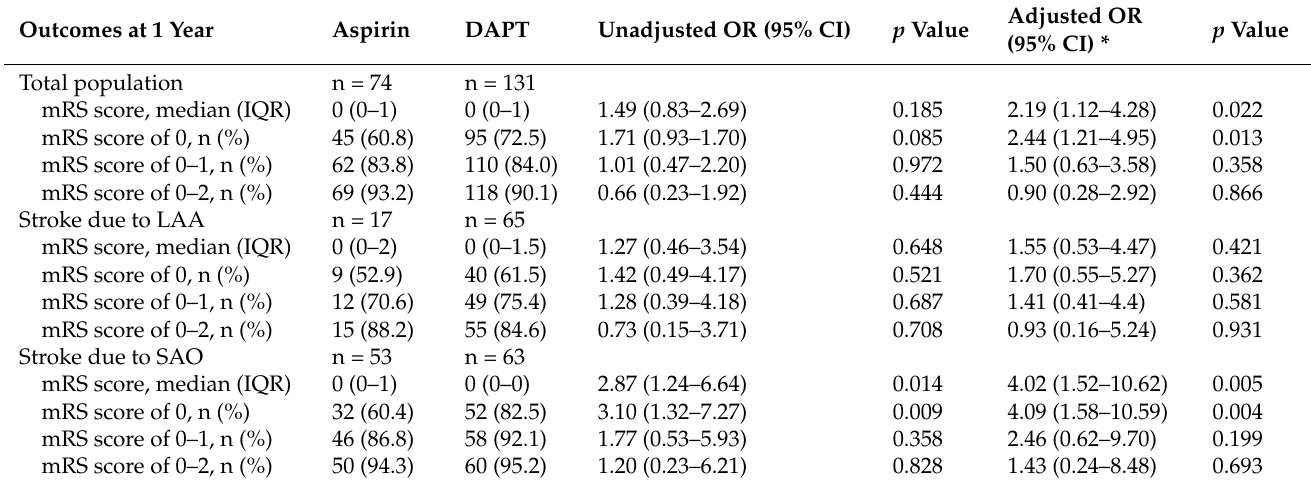
Figure 2. Distribution of modified Rankin Scale scores for patients with minor stroke treated with DAPT and aspirin monotherapy at 1 year. Table 2. Outcomes and treatment effects for patients with minor stroke at 1 year.